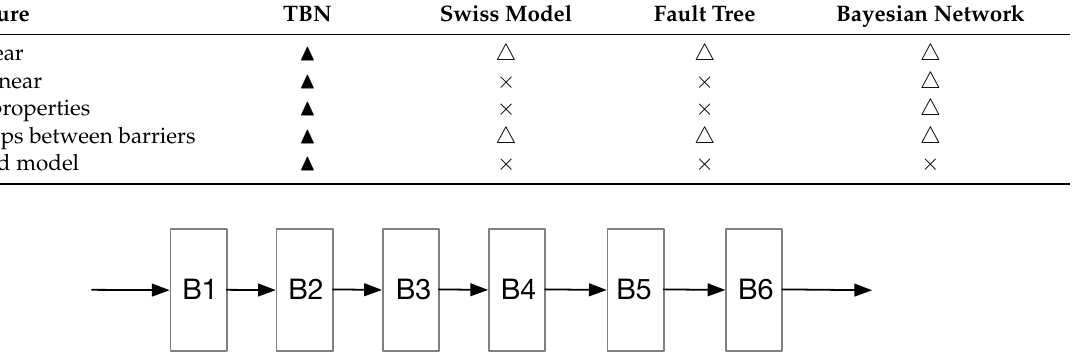
Figure 4. Swiss model for train derailment (please refer to Tables 1 and 3 for the meanings of the